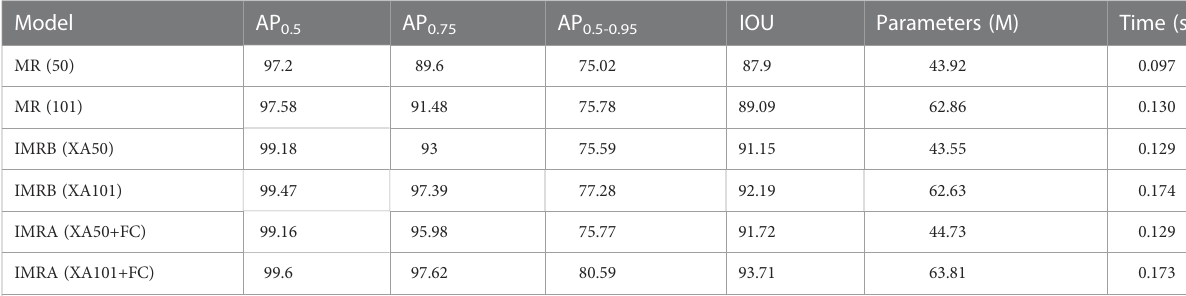
TABLE 1 Performance results of different models in the test set. Model